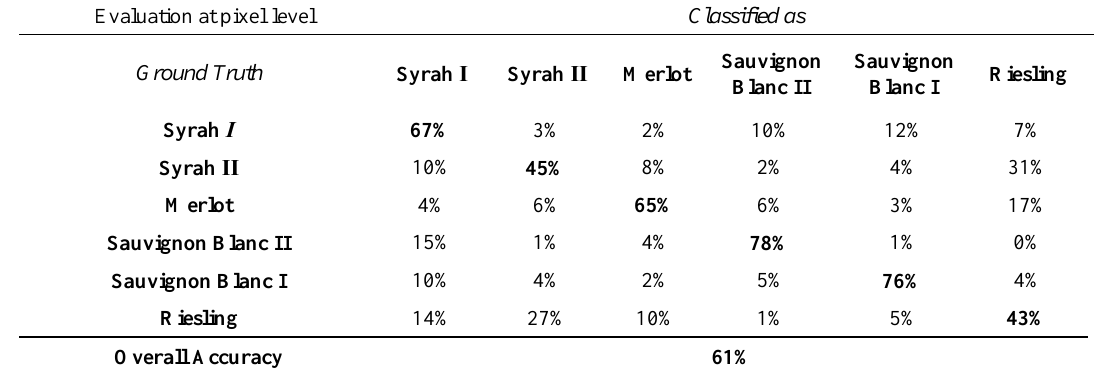
Table 1. Quantitative evaluation results at pixel level for the Trapeza study